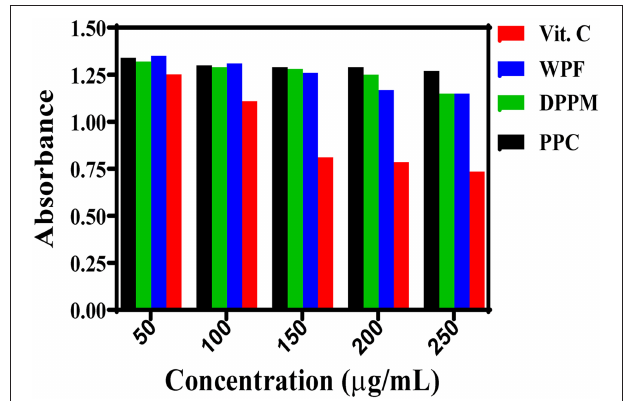
FIGURE 1 | Dose-response DPPH radical scavenging effects of different peanut protein preparations (WPF, whole peanut flour; DPPM, defatted peanut protein meal; PPC, peanut protein concentrate) in comparison to a natural antioxidant (Vit.